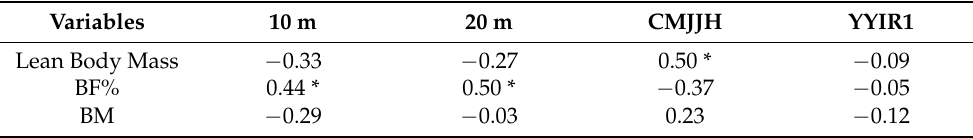
Table 1. Correlations between Body Composition and Sprinting, Jumping, and Intermittent En- durance Performance.